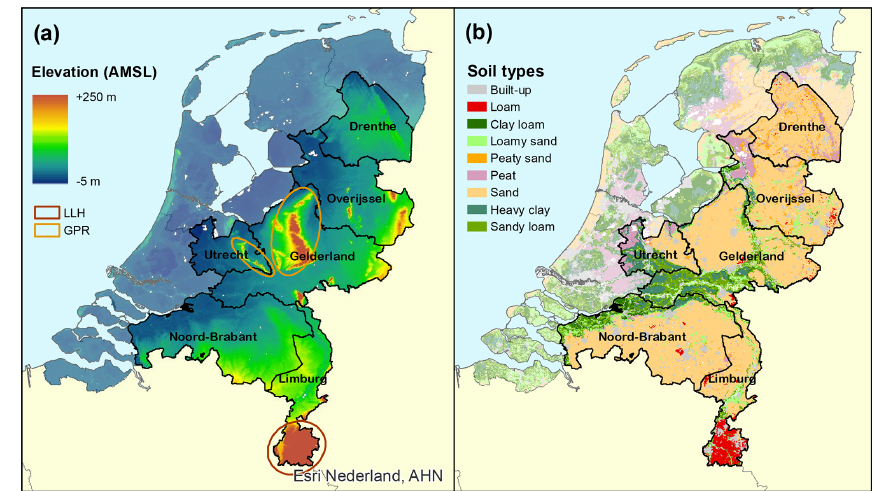
Figure 1. The study area, showing (a) elevation (AHN, 2019) and (b) soil types (WUR, 2006). The higher-elevation limestone–loess hill landscape in southern Limburg (LLH) and glacier-pushed sand ridges (GPR) are